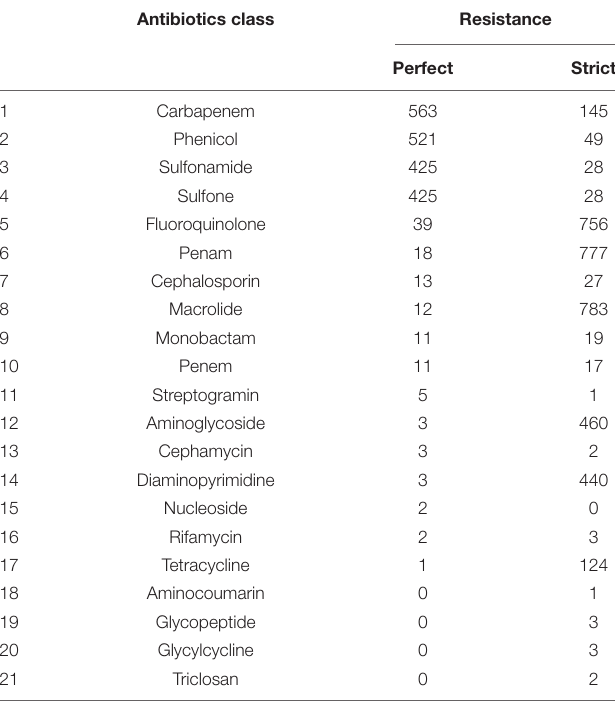
TABLE 1 | Drug resistance predicted from the V. cholerae